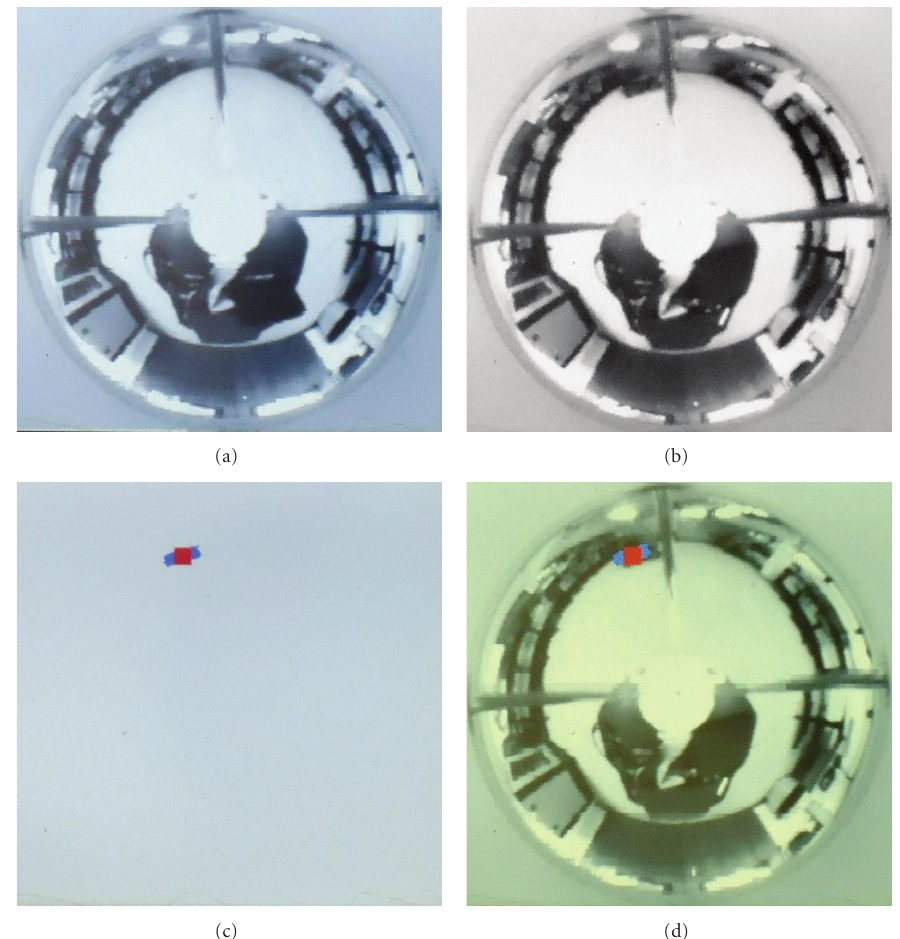
Figure 15: Results of the image processing chain: (a) background, (b) new frame, (c) subtraction, and (d) overlap.